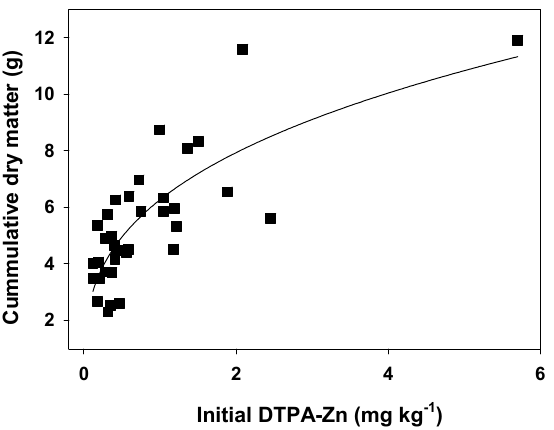
Figure 5. Relationship between the cumulative dry matter yield in the four crops (g) and the initial DTPA extractable Zn (mg kg –1 ) in soils. Y = 1.9 + 4.2 X –0.5 ; R 2 = 0.61; p < 0.0001. Regression for transformed variables to meet normality criteria is: Ln Y = 1.79 + 0.31 Ln X; R 2 = 0.56; p < 0.0001. The DTPA-Zn threshold value for DM yield in the first crop was 0.5 mg kg –1 ( R 2 = 0.29); meanwhile, that value for Zn uptake in this first crop was 0.75 mg kg –1 ( R 2 = 0.37).